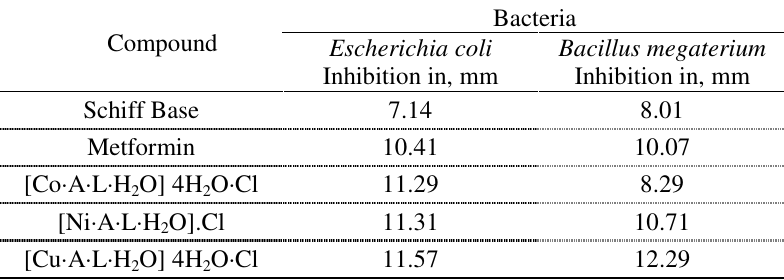
Table 7. Effect of ligand and metal complexes on the growth of